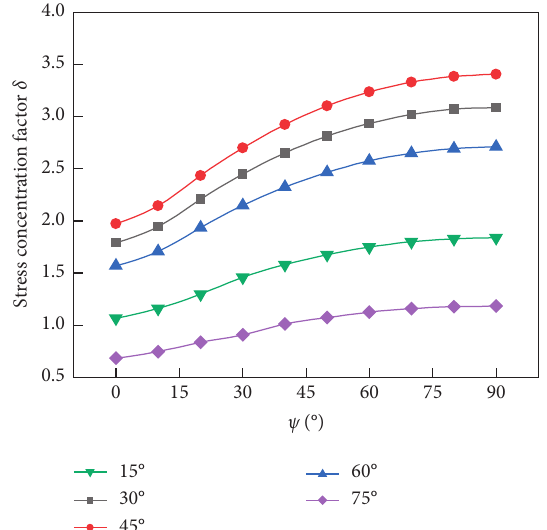
Figure 8: Variation of stress concentration factors δ with elliptic polar angle ψ.